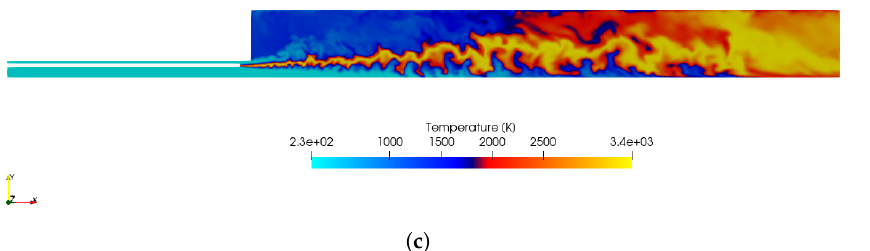
Figure 2. ( a ) Schematic of the geometry of the shear-coaxial injector used; key geometry parameters are specified. The fuel and oxidizer inlet channels and the outlet are identified; all adiabatic-slip walls are colored in black. ( b ) Three-dimensional view (3D) of a representative domain used in the confection of the LES database of shear-coaxial injectors. ( c ) Longitudinal cut of the instantaneous temperature field of one sample from the LES dataset of shear-coaxial injectors. Corresponding values are: l r = 1.92 mm, d c = 11.22 mm, and O / F = 2.445. The numerical schemes used are the Lax-Wendroff scheme (LW) [51] for the convective terms and a 4th-order finite-element scheme for the diffusive terms (FE4 ∆ ). The limit